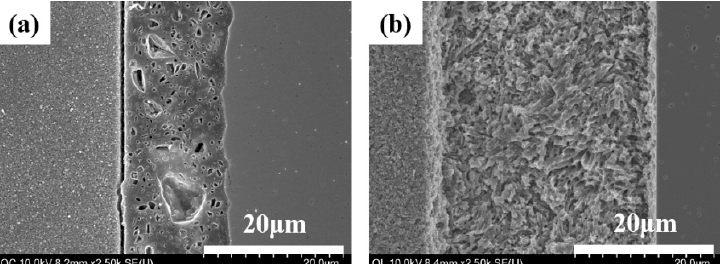
Figure 5. HR FE-SEM images of bonded interface between lithium disilicate-reinforced glass ceramic